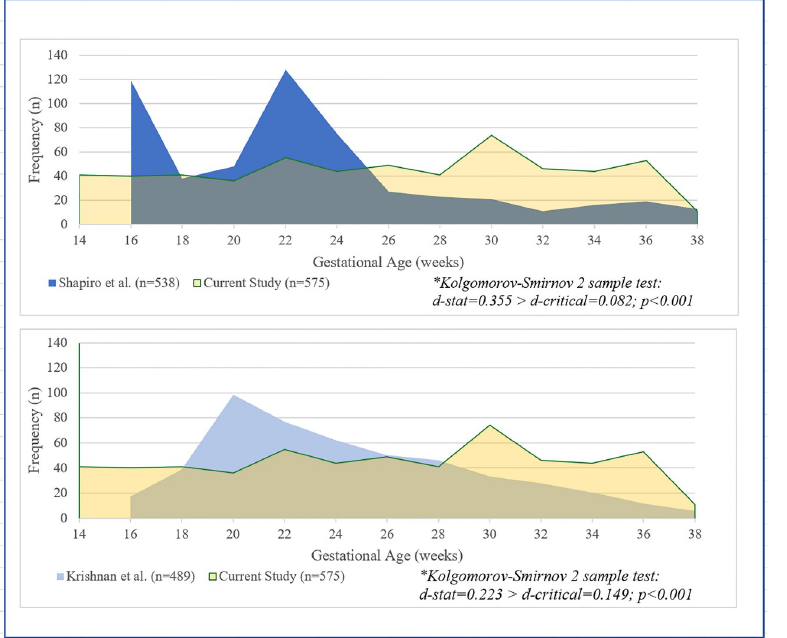
Fig 1. a, b. Distribution of cases compared to past studies with normal ranges for heart